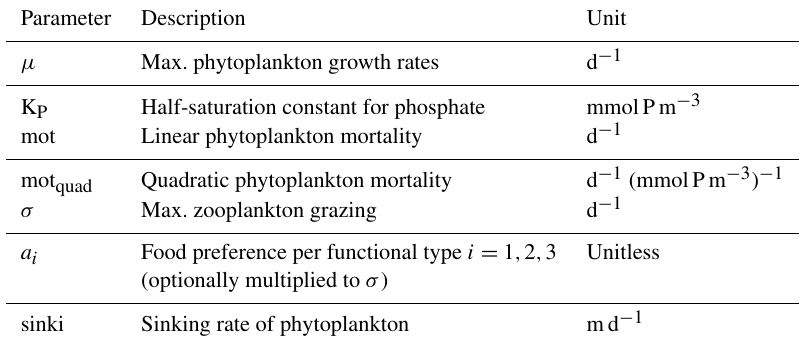
Table 2. Description and units of the ecosystem model parameters considered in this study. The focus is on those parameters that differ among the different functional groups.